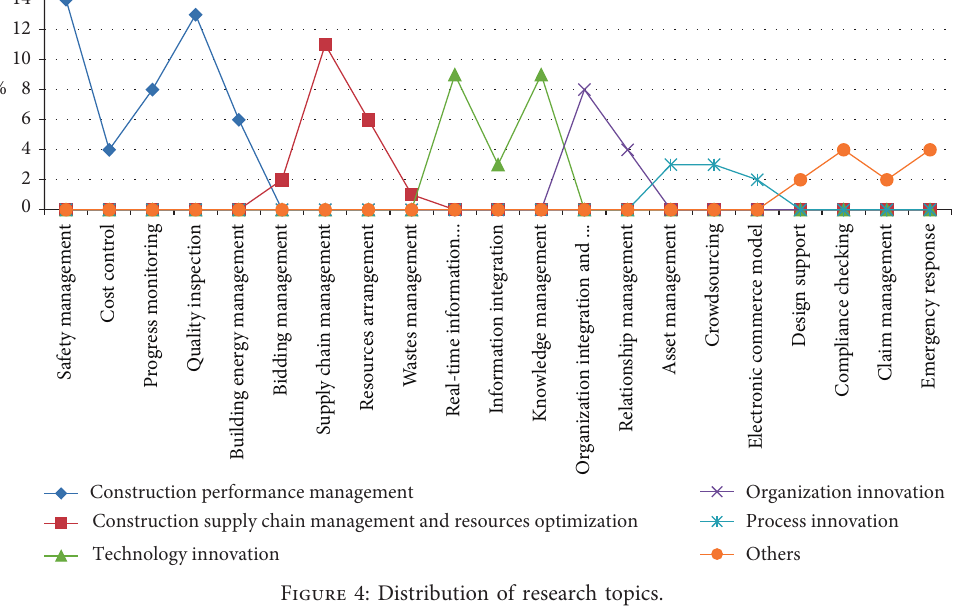
Figure 4: Distribution of research topics.